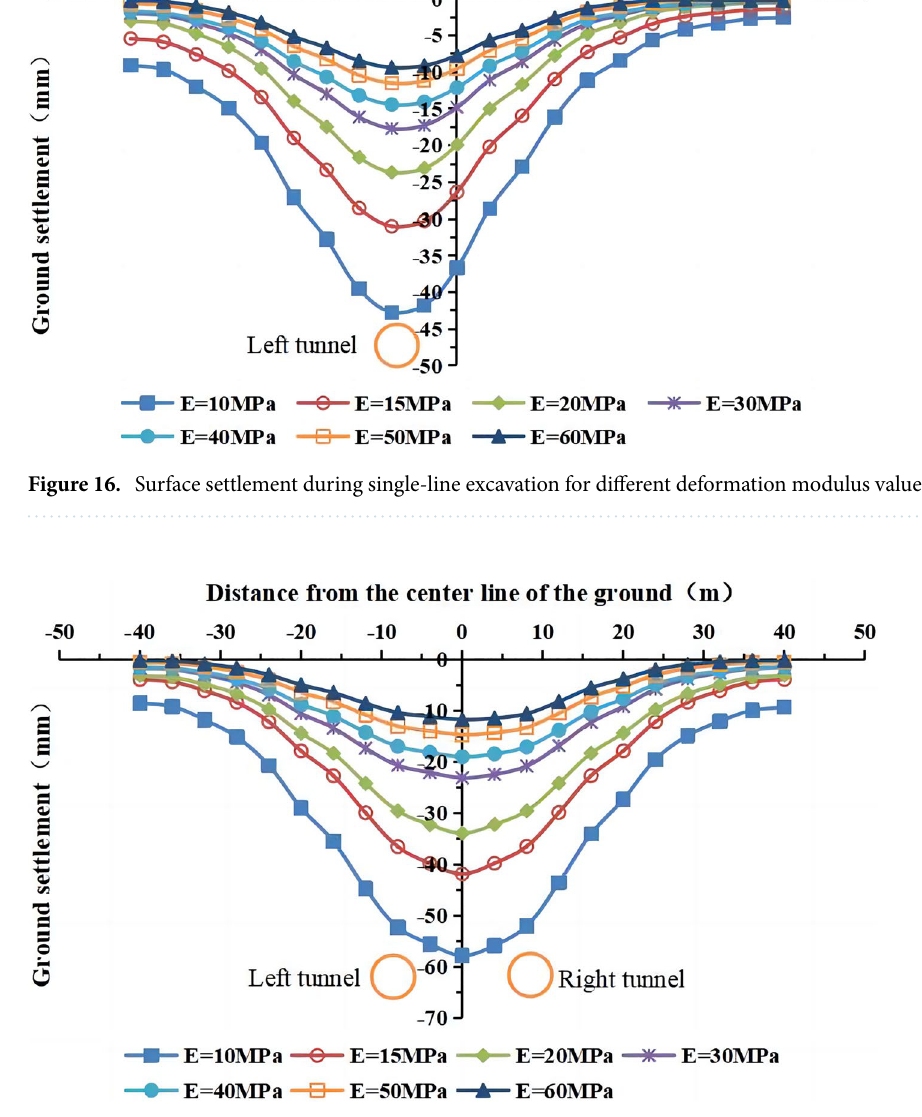
Figure 17. Surface settlement during double-line excavation for different deformation modulus